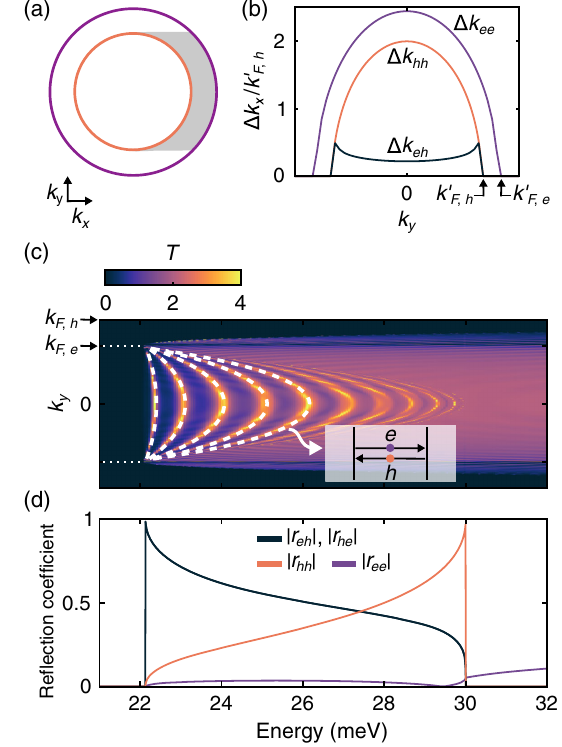
FIG. 4. (a) Two Fermi circles from Fig. 3(a) with the larger (smaller) circle being the Fermi circle of electronlike (holelike) states. The shaded region marks the momentum transfer Δ k x for the eh scattering processes assuming conservation of k y ; Δ k x does not depend strongly on k y . (b) Momentum transfer Δ k x as a function of k y for the various scattering processes ij from Fig. 3(b). Here, Δ k eh and Δ k he are identical. k F;e ( k 0 F;e ) and k k 0 F;h ( F;h ) are Fermi wave numbers of electronlike and holelike states in the leads (cavity), respectively. (c) Transmission T through the pn 0 p junction as a function of the Fermi energy E 0 in the n 0 -doped cavity and the momentum k y of the incident wave, calculated using a scattering matrix approach. The dashed lines denote the constructive interference condition assuming eh and he scattering only [Eq. (5) and inset]. The minimum of the hybridized conduction band is located at 22.1 meV. (d) Reflection amplitudes j r ij j for the various scattering processes ij from Fig. 3(b) plotted as a function of E 0 and for k y ¼ 0